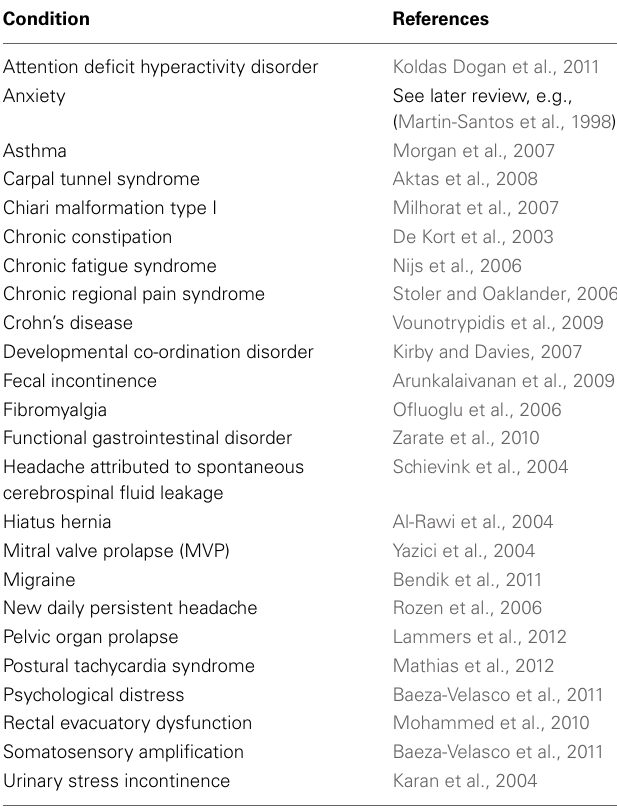
Table 1 | Diagnostic criteria of JHS/EDS